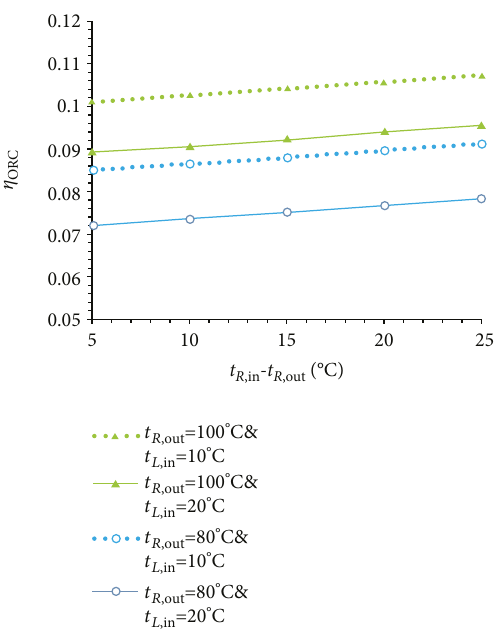
- t = 5 ° C ). R ,in R ,out